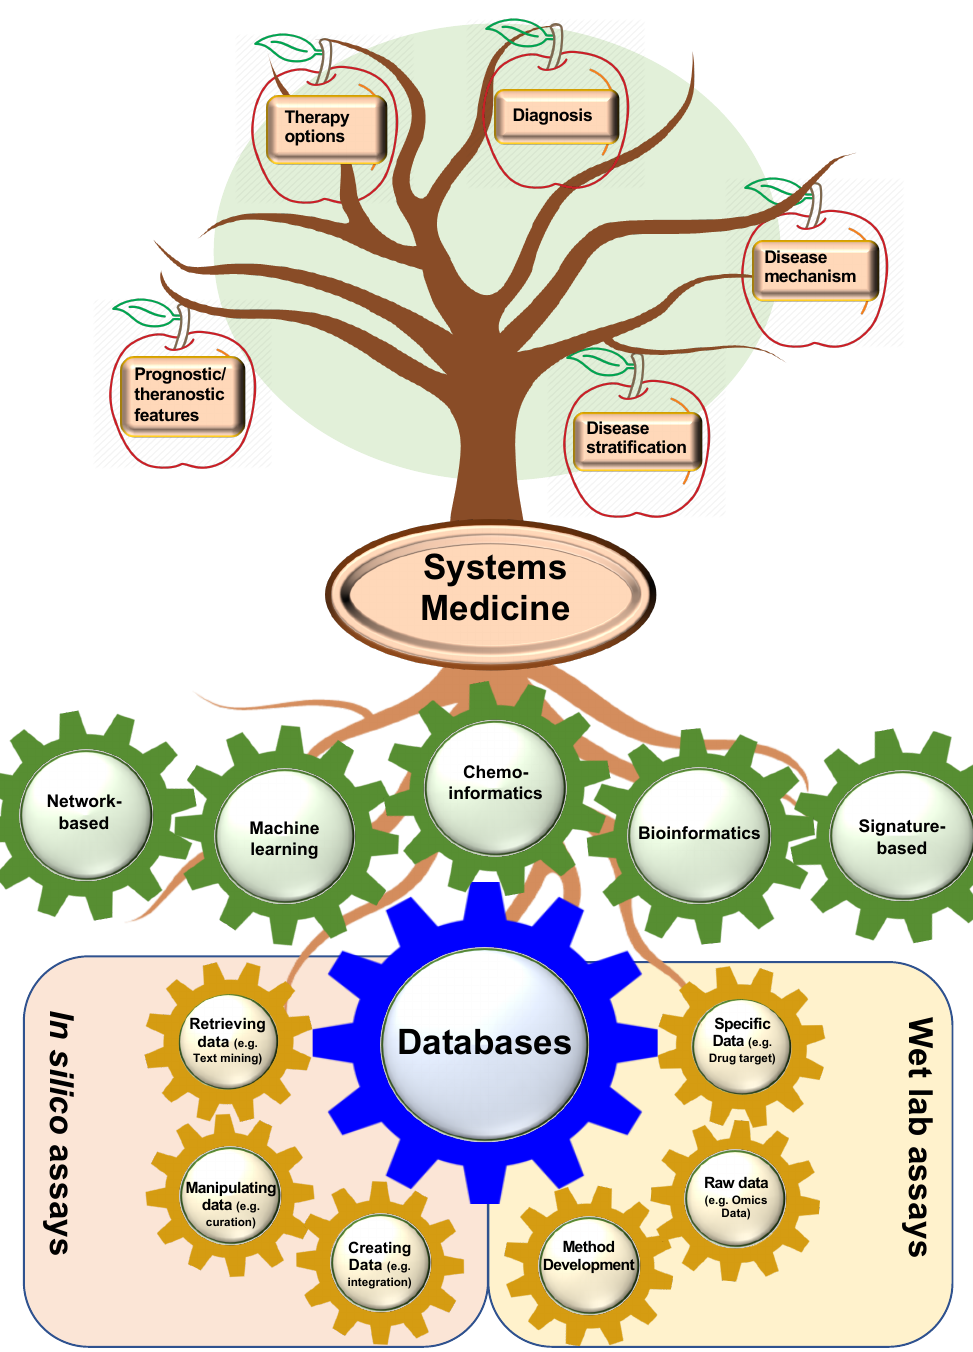
Figure 5. From bottom to the top, this is the whole story of current e ff orts to find repositionable drug candidates for emerging disease. DBs, as the foundation of drug repositioning, can be created from various computational and experimental approaches. The second way of categorizing DBs (assay-based classification) is depicted here as three in silico and three laboratory-based approaches in yellow gears to construct a DB. Afterwards, DBs can pave the way for various categorizations of systems medicine (shown in green gears) to decipher many probabilities in the case of disease mechanisms; disease stratification; therapy options; and diagnostic, prognostic, or theranostic features of